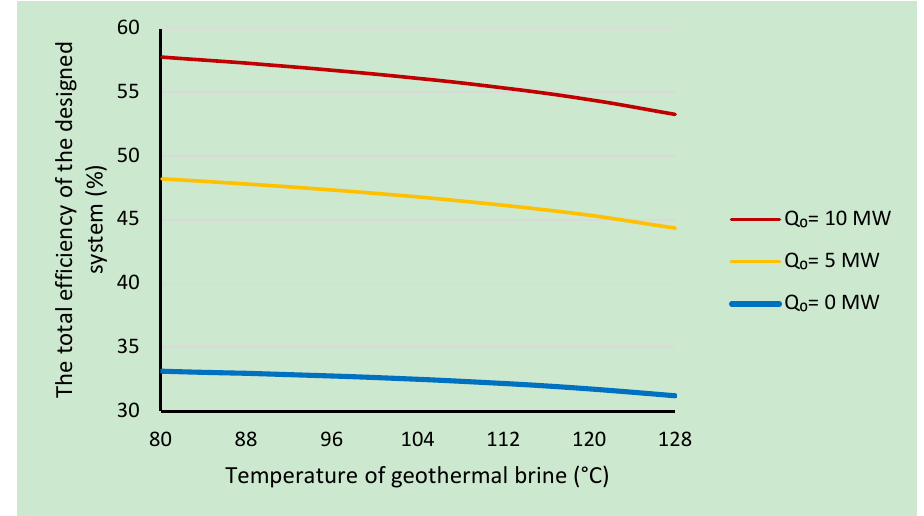
Figure 8. Impact of changing the amount of heat produced on the total efficiency of the proposed installation.